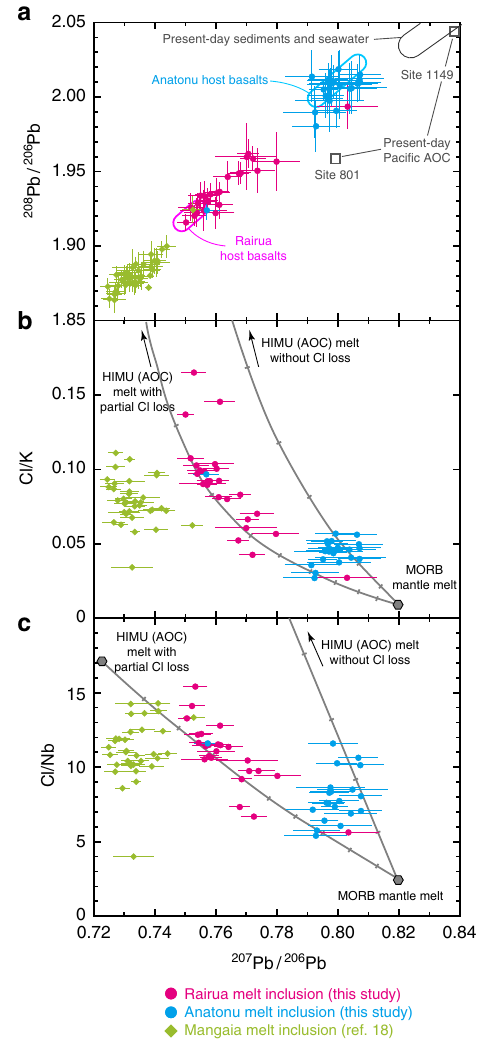
Fig. 1 Melt inclusion Pb isotopes and Cl-to-lithophile element ratios. a 207 Pb/ 206 Pb versus 208 Pb/ 206 Pb. b 207 Pb/ 206 Pb versus Cl/K. c 207 Pb/ 206 Pb versus Cl/Nb. The inclusions in the Rairua and Anatonu basalts from Raivavae are indicated by the purple and light-blue symbols, respectively (this study). For comparison, Mangaia basalt inclusions are indicated by green symbols 18 . Error bars with the 207 Pb/ 206 Pb and 208 Pb/ 206 Pb data of this study are bracketing standards propagated in-run 2 S.E. (standard errors). The Pb isotopic ranges of Raivavae (Rairua and